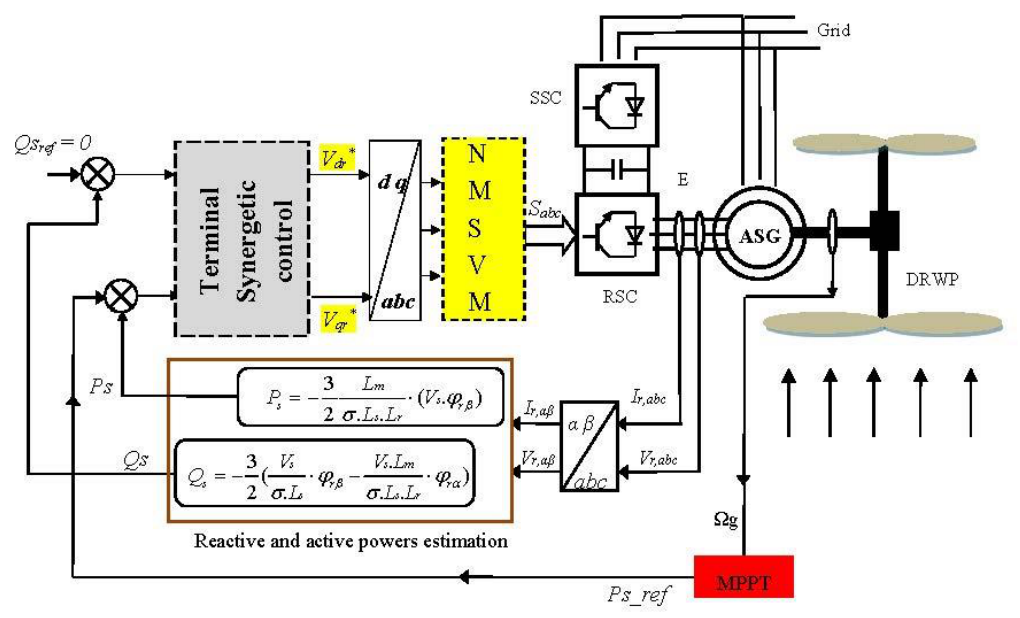
Figure 2. DARPC system of ASG with the applications of proposed terminal synergetic control.